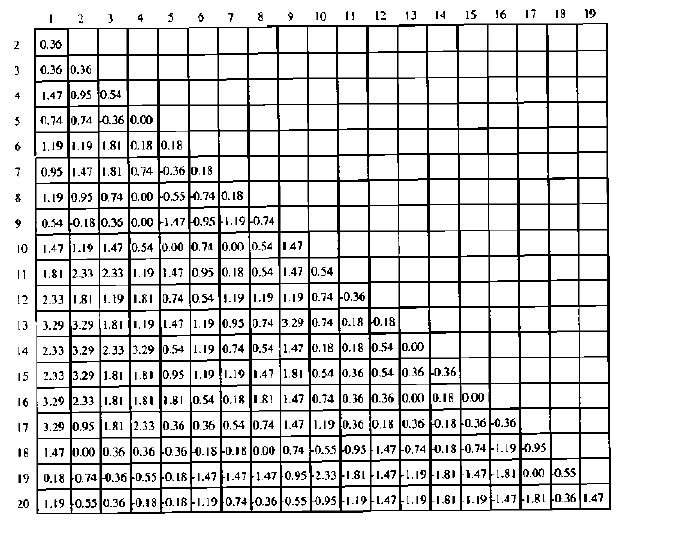
FIGURE 3. Pitch discrimination matrix for subject REK. The values in the table are the calculated d' values. Positive values of d' indicate that the elec- trode numbered at the top was judged higher in pitch than the electrode numbered at the left more than half of the time. For normal tonotopic organi- zation, the d' values are expected to be positive, as electrode 1 is the most basal electrode and electrode 20 the most apical. REK had a region of good pitch discrimination toward the left side of the matrix.